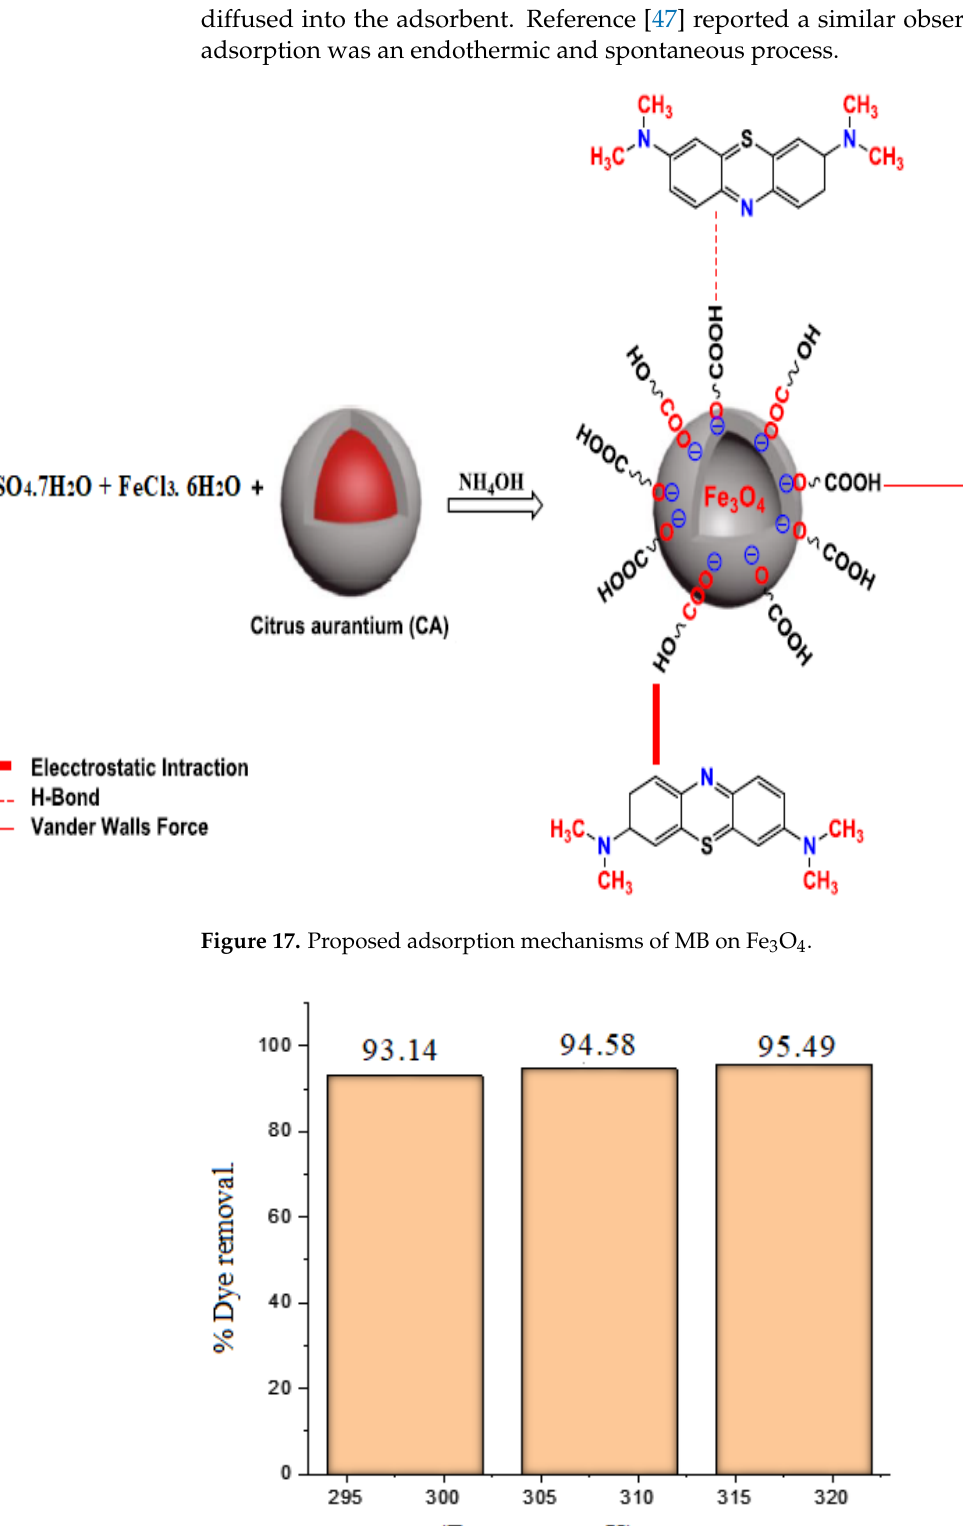
Figure 18. Influence of the temperature on the perecentage dye removal.